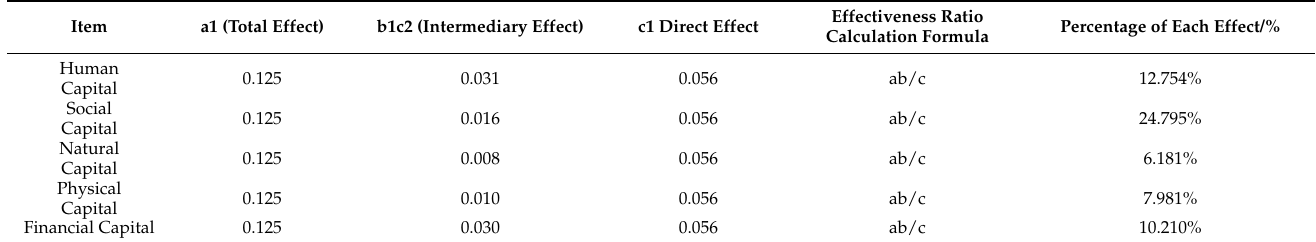
Table 7. Size of the mediation